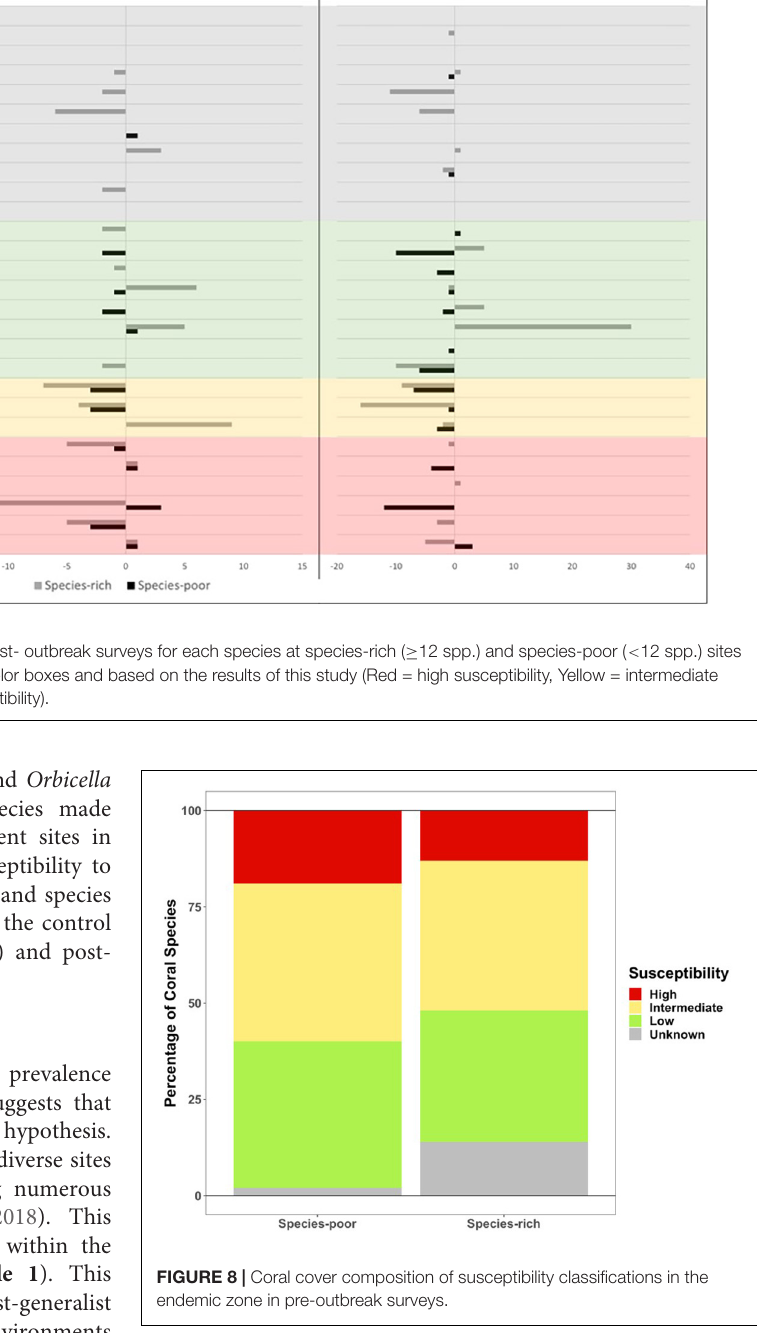
More significant positive relationships between disease prevalence and diversity may not have been detected because of variation in the lengths of time that sites were affected with SCTLD. Epidemic zone sites were affected from anywhere between 2 and 6 months, resulting in a range of severity and spread of disease at sites. A monitoring study in the Middle Florida Keys first reported SCTLD in March of